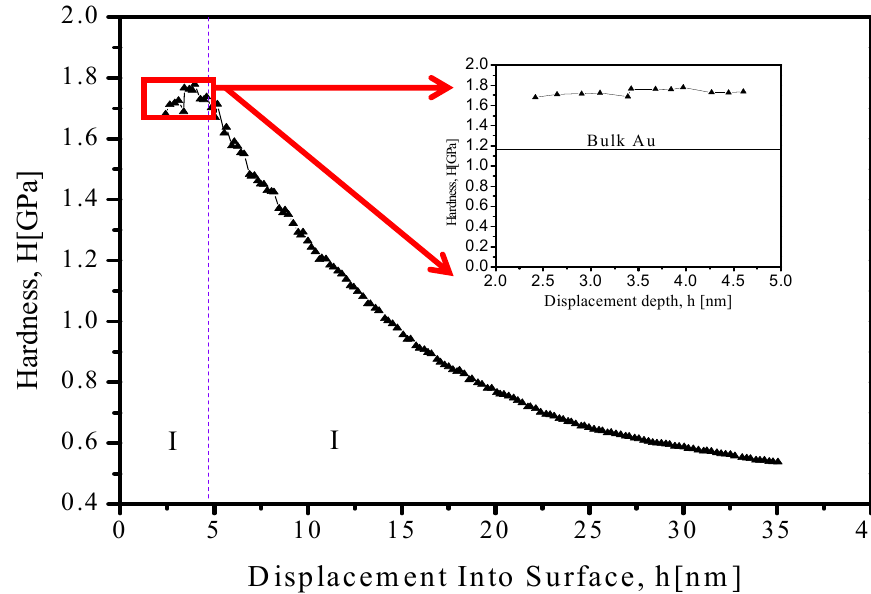
Figure 3. Measurements of hardness and function of displacement from CSM nanoindentation of Au-NP. Inset: Specific region between 2.5–6.0 nm of displacement, indicating a 1.72 ± 0.03 GPa value. Horizontal dotted line corresponds to values found for gold in bulk phase